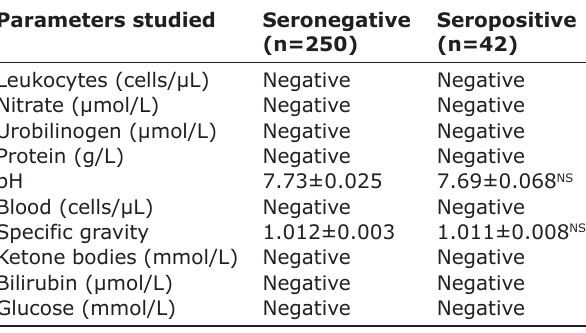
Table-3: Details of urine analyses (mean±SE) in goats. Parameters